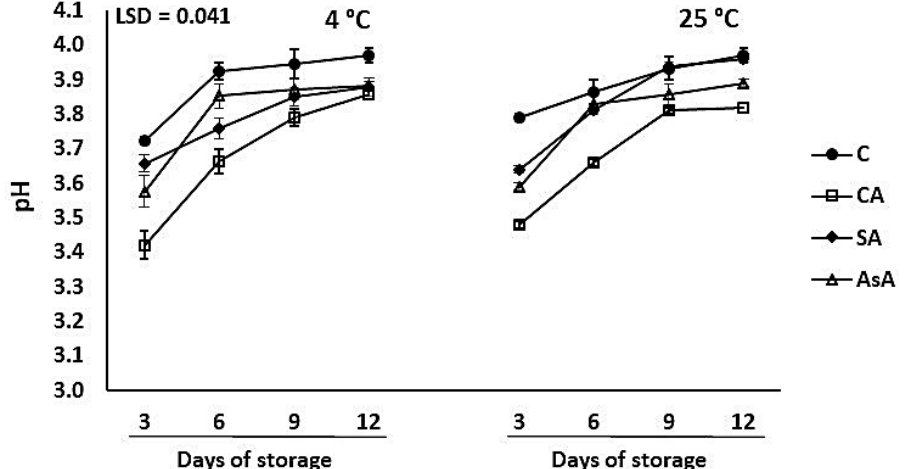
Figure 6. Effects of bio-stimulants B, control (C), citric acid (CA), salicylic acid (SA) and ascorbic acid (AsA), storage period SP (3, 6, 9 and 12 days) and storage temperature T (4 ◦ C and 25 ◦ C) on pH of okra pods. Error bars are the ± SD of the means of three biological replicates for each temperature condition. LSD values ( p ≤ 0.05) for B = 0.02, SP = 0.02, T = 0.01, B × SP = 0.03, B × T = 0.02 and SP × T = 0.02. LSD for B × SP × T is presented on the figure.